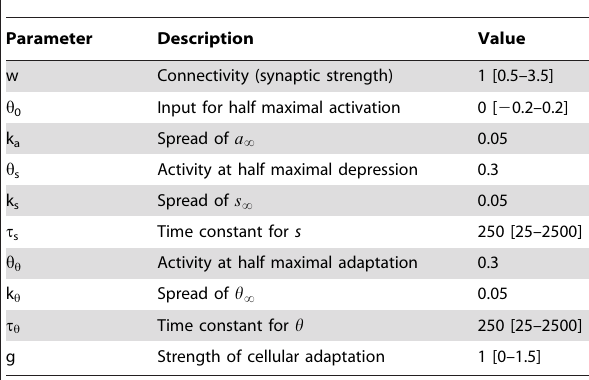
Table 1. Parameters of the